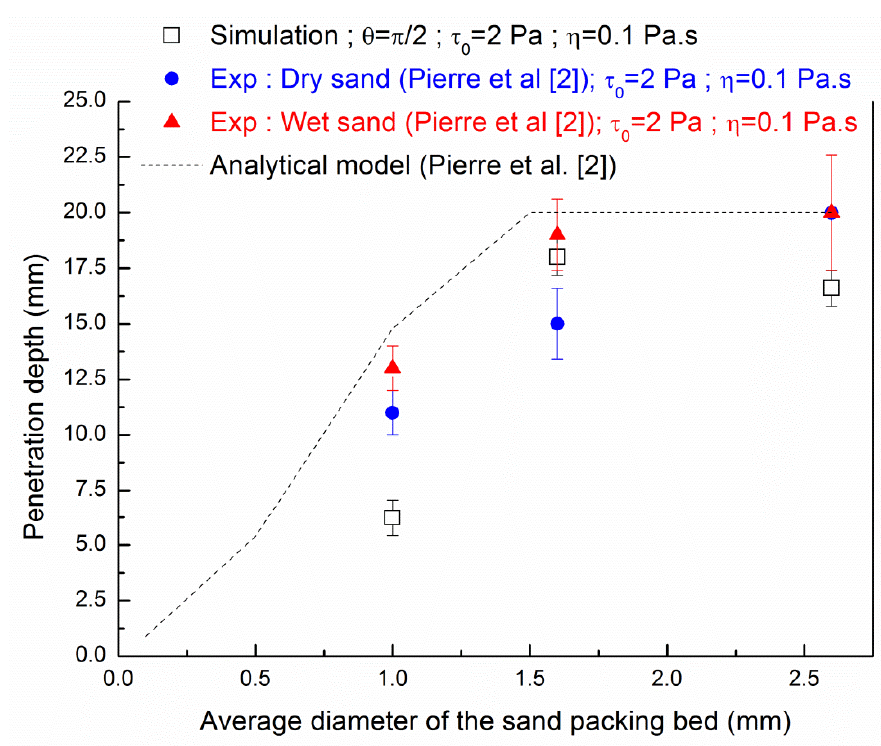
Figure 11. Comparison of the numerical penetration depth of cement paste 𝜏 0,𝑒𝑥𝑝 = 2 Pa; 𝜂 𝑒𝑥𝑝 = 0.1 Pa · s) and the experimental results and analytical model from Pierre et al. [27].